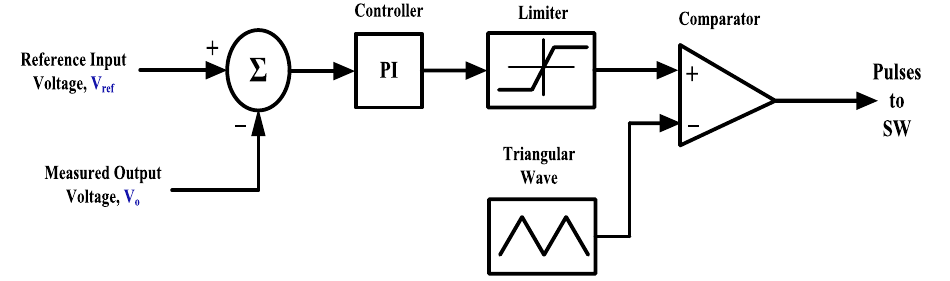
Figure 16. A schematic diagram of closed loop control circuit.